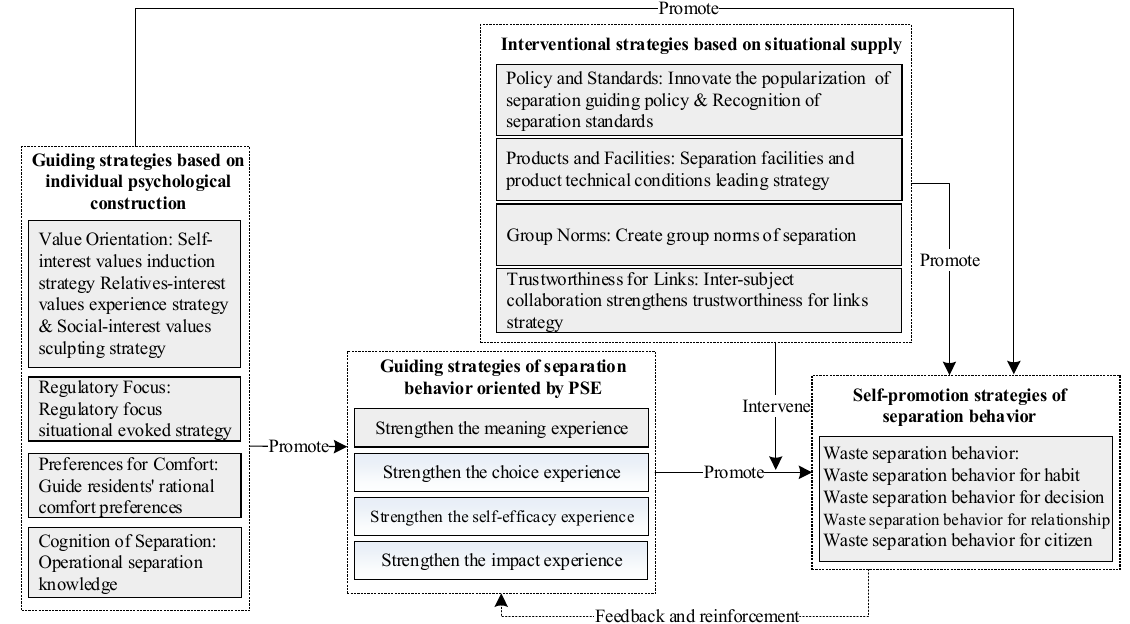
Figure 3. Frame of driving recommendation of waste separation behavior.